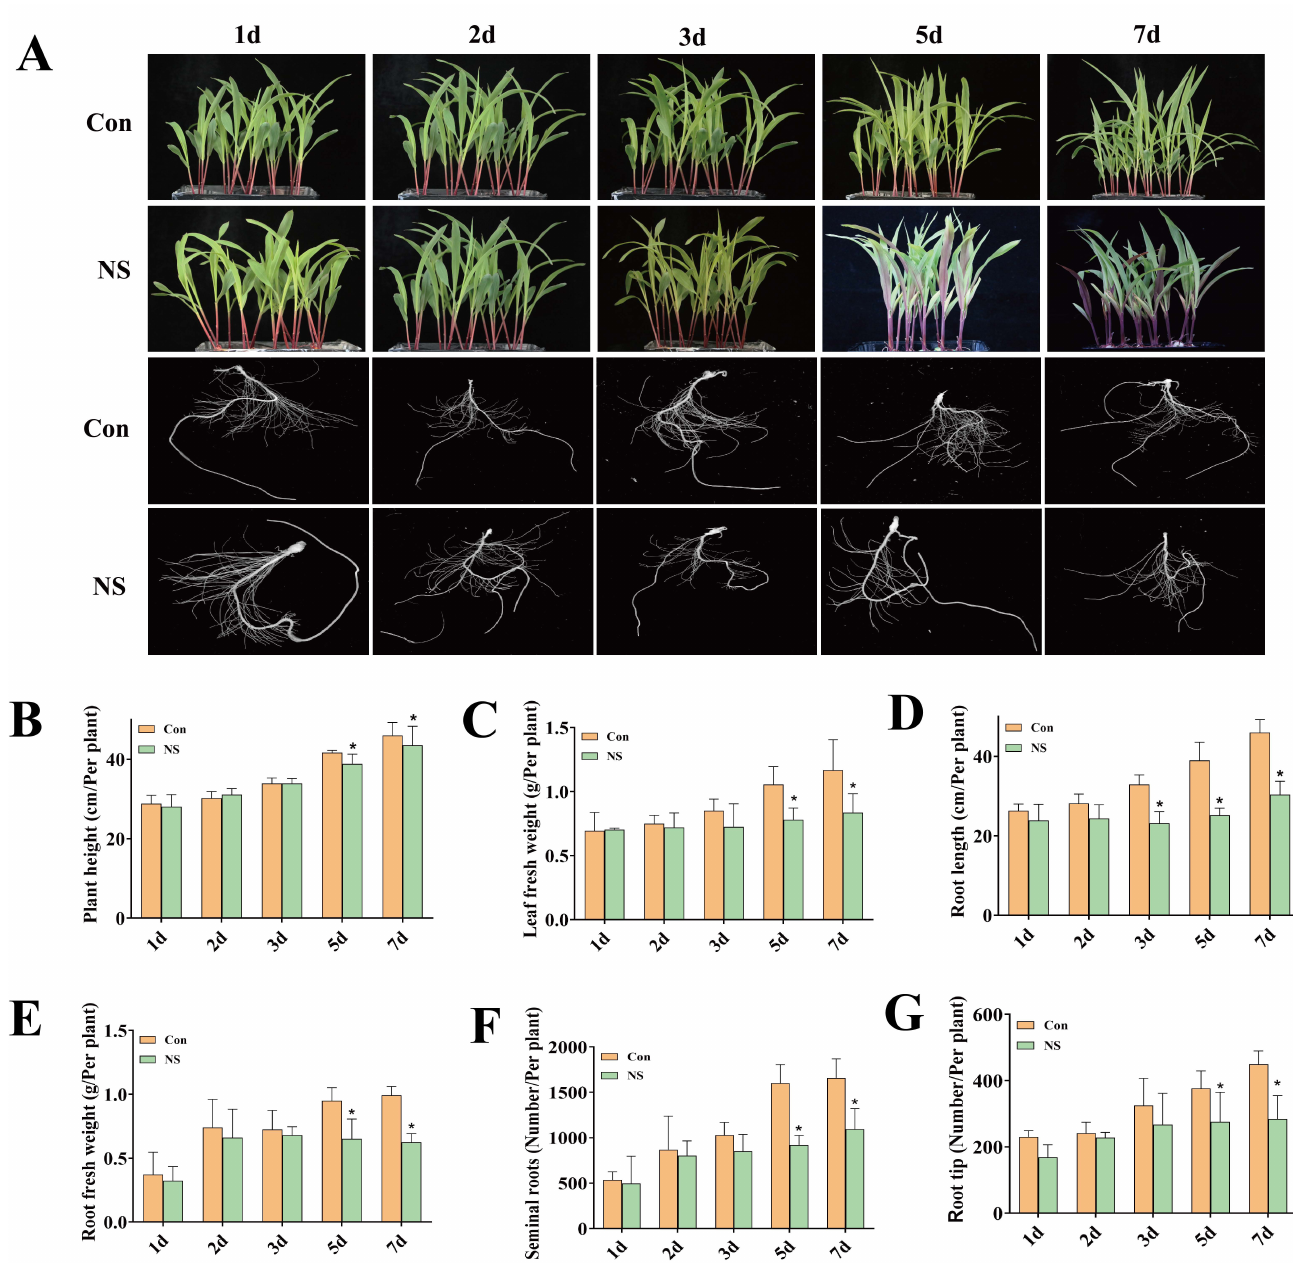
Figure 1. Physiological phenotypes of maize seedlings under phospholipase C inhibition. ( A ), photos of maize seedlings; ( B ), plant height (Con: Control, NS: 100 mM of neomycin sulfate); ( C ), leaf fresh weight; ( D ), root length; ( E ), root fresh weight; ( F ), number of seminal roots; ( G ), number of root tips. Values are shown as mean ± SD ( n =3 individuals per group). * means that the difference from the control reaches a significant level, p <